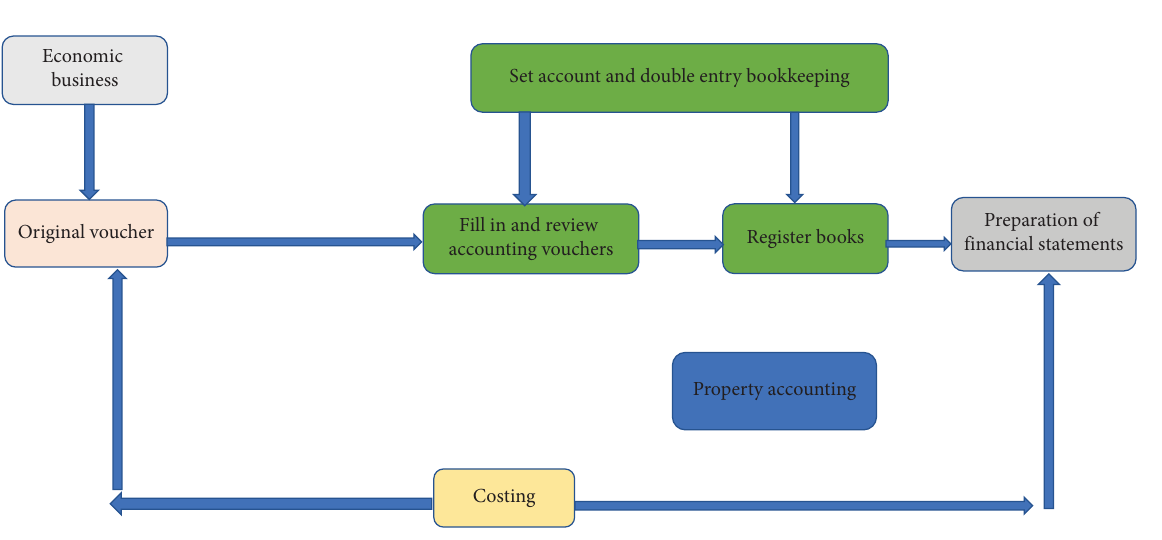
Figure 6: Accounting method.